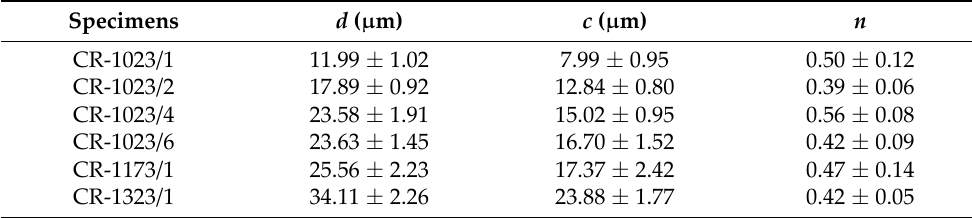
Table 2. Mean grain sizes ( d ), crystallite sizes ( c ), and number of annealing twin boundaries per grain ( n ) of the alloys after heat treatment at different temperatures and